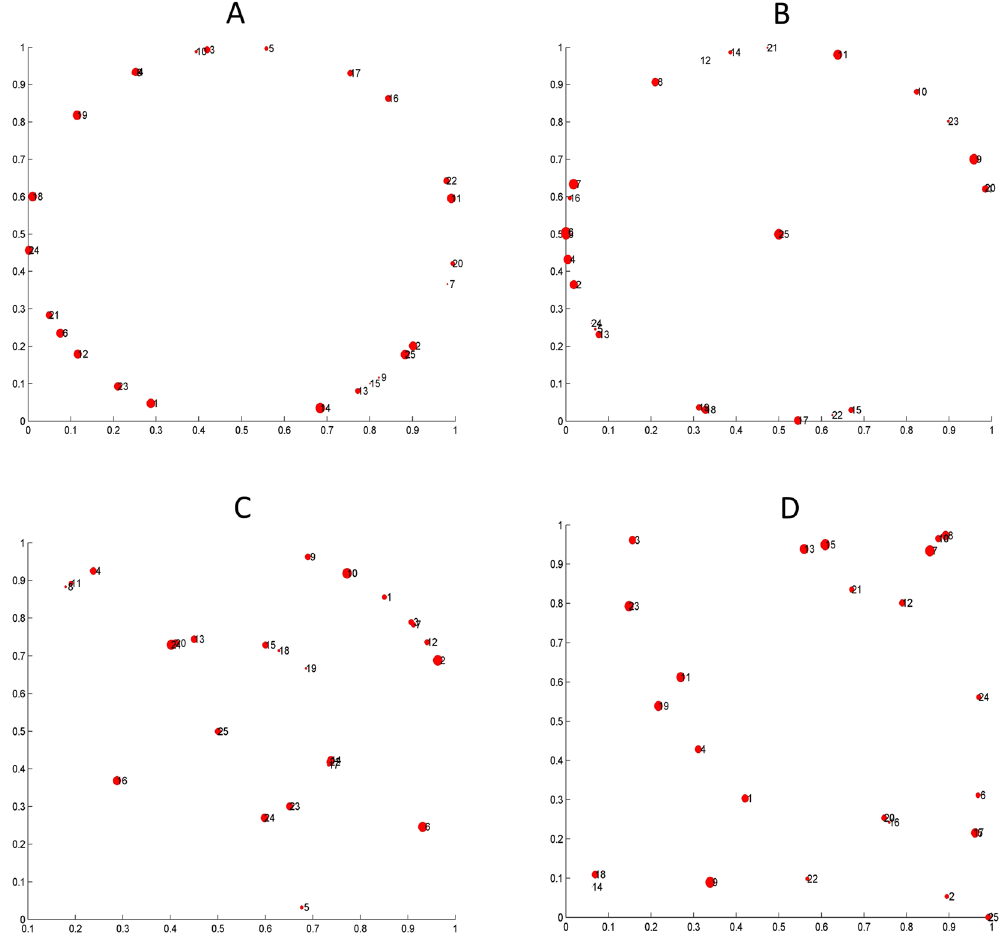
Figure 2. Representative examples of the different geographical distributions considered. ( A ) Circunference setup. This corresponds to the case of an island whose center is difficult to access, so communications take place along the coast such as, e.g., Iceland. ( B ) Circunference and central point setup. Regions with a large part of the population leaving in the periphery and in a central town. ( C ) Double circunference and central point setup. As in ( B ), but with a belt of intermediate towns between the center and the periphery, typically less populated thanthe others. ( B and C ) Exemplify countries such as France or Spain, while choosing ( B or C ) for the description depends on the relevance (actual or modeled) of the intermediate towns. ( D ) Random setup. Towns are uniformly distributed in the considered region, such as in, e.g., Germany, where such a distribution arises from a history of small kingdoms that became integrated only